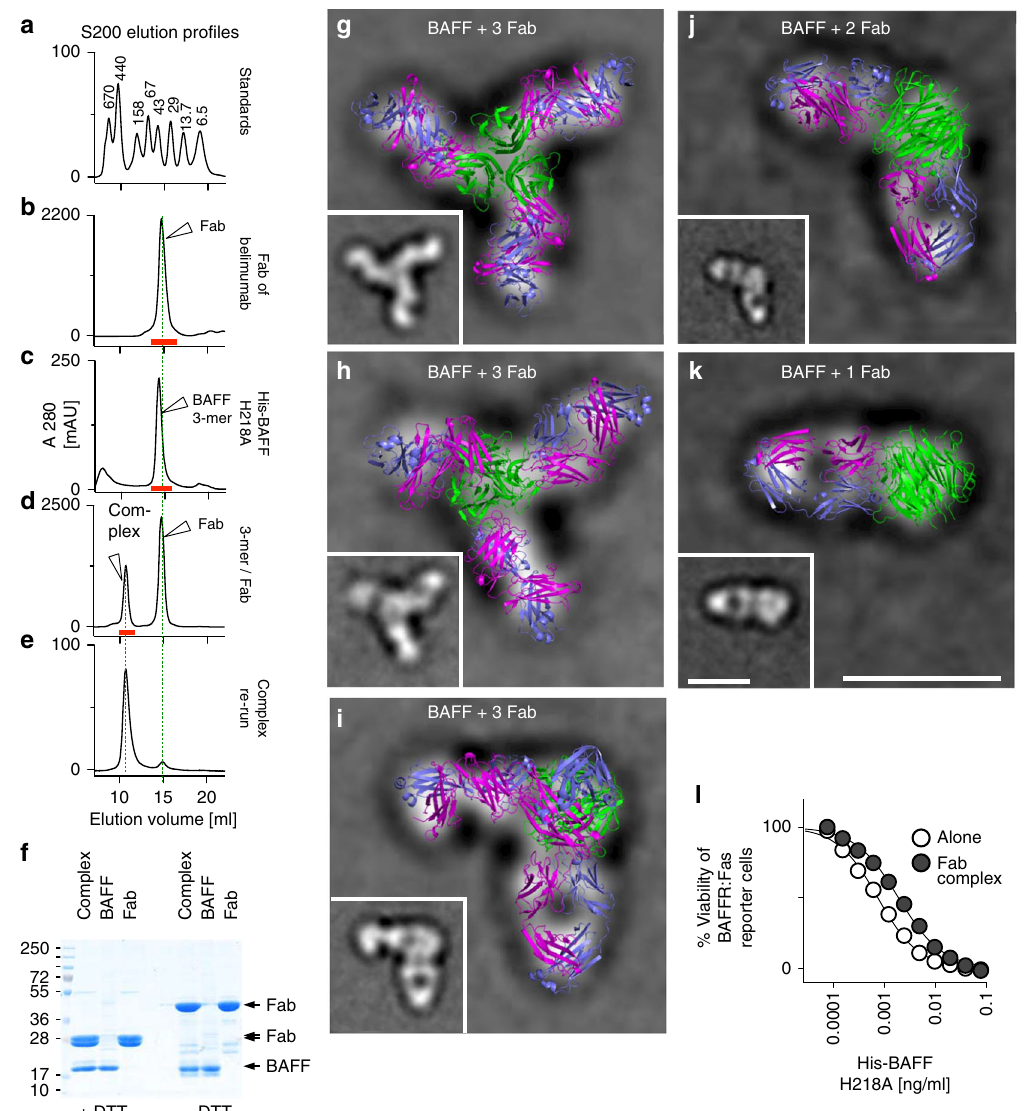
Fig. 7 Structure of the BAFF – belimumab Fab complex. The Fab of belimumab was generated by papain digestion, and a 3-mer of BAFF was obtained by expression of BAFF H218A in bacteria. The complex formed by the association of BAFF 3-mer with belimumab Fab was isolated by size-exclusion chromatography and characterized by electron microscopy and by crystallography. The activity of BAFF 3-mer alone or in complex with belimumab Fab was tested on BAFFR:Fas reporter cells. a Elution pro fi le of molecular weight standards by size-exclusion chromatography. b Elution pro fi le of belimumab Fab. The experiment was performed twice. c Elution pro fi le of His-BAFF H218A. The experiment was performed twice. d Elution pro fi le of BAFF 3-mer mixed with an excess of belimumab Fab. The experiment was performed twice. For panels b , c , and d , collected fractions are indicated by the underlying red line. e Elution pro fi le of the isolated BAFF – belimumab Fab complex. The experiment was performed twice. f 5 µ g of BAFF 3-mer, 15 µ g of belimumab Fab, and 20 µ g of the BAFF – Fab complex were analyzed by reducing ( + DTT) or non-reducing ( − DTT) SDS-PAGE and Coomassie blue staining. The migration positions of BAFF and of the Fab chains are indicated on the right. The experiment was performed twice. g – k Superposition of typical electron microscopy negative stain images with the crystal structure of the BAFF – belimumab Fab complex. Note that in panels j and k , respectively one and two Fab were removed from the crystal structure. The experiment was performed once. Scale bars: 100 Å. l Biological activities of BAFF 3-mer and of BAFF – belimumab Fab complexes were measured on reporter cells. The experiment was performed three times. See also Supplementary Table chromatography (Fig. 9a, b). When BAFF 60-mer was mixed organized, capsid-like structure of about 220 Å diameter (Fig. 9g, with an excess of atacicept on ice, a heavy precipitate formed, pictures on the left) 19 . In the presence of atacicept, these particles enlarged to a diameter of about 340 Å, indicating that they had and the supernatant only contained excess soluble atacicept with been coated with atacicept without affecting assembly of the no trace of complex (Fig. 9c). However, when resuspended in underlying BAFF 60-mer (Fig. 9g, pictures on the right). We buffer, the precipitated complex reversibly dissolved at room conclude from these studies that although atacicept and beli- temperature and re-precipitated on ice (Fig. 9d). The mumab share common features for BAFF binding (the DXL atacicept – BAFF 60-mer complex could therefore be isolated by motif), they differ by their binding ability to un-dissociated BAFF size-exclusion chromatography at room temperature (Fig. 9e, f). 60-mer. Analysis of BAFF 60-mer by electron microscopy revealed a well-